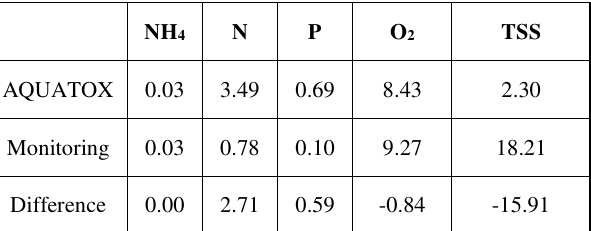
Table 3. Comparison between AQUATOX results and monitored values for concentrations of some pollutants (every concentration is expressed in